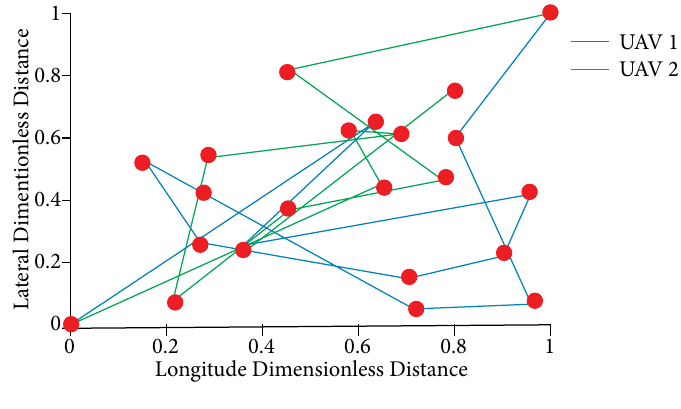
Figure 4. The first iteration for 2 UAVs patrolling.